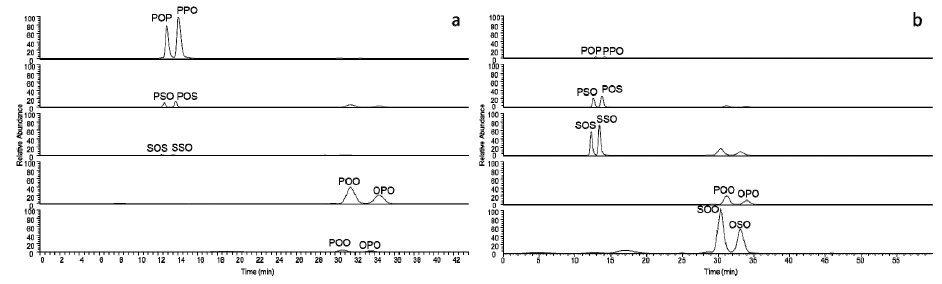
Figure 3. Chromatographic separation of TAG regioisomers typical of interesterified Shea oil ( a ) and Palm oil ( b ) visualized at the extracted precursor ion m/z values.